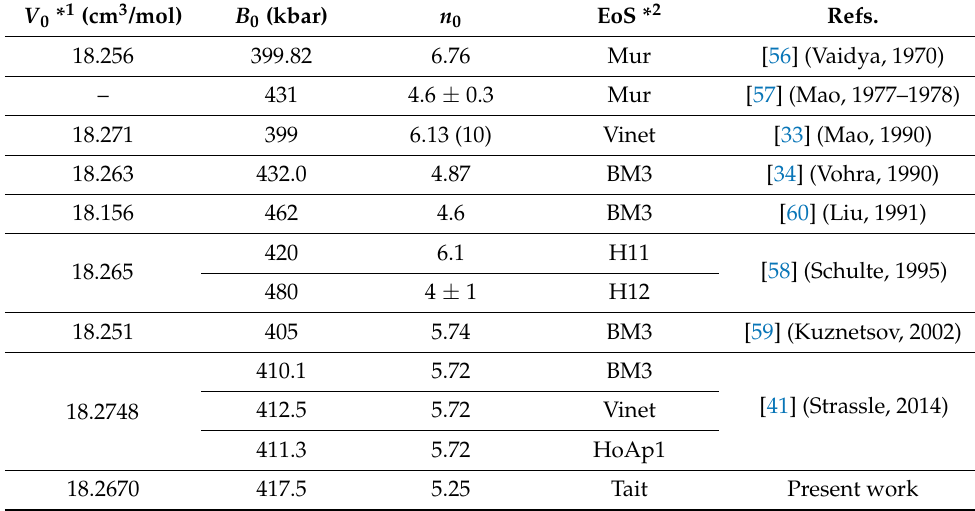
Table 6. Parameters of EoS for the fcc phase of